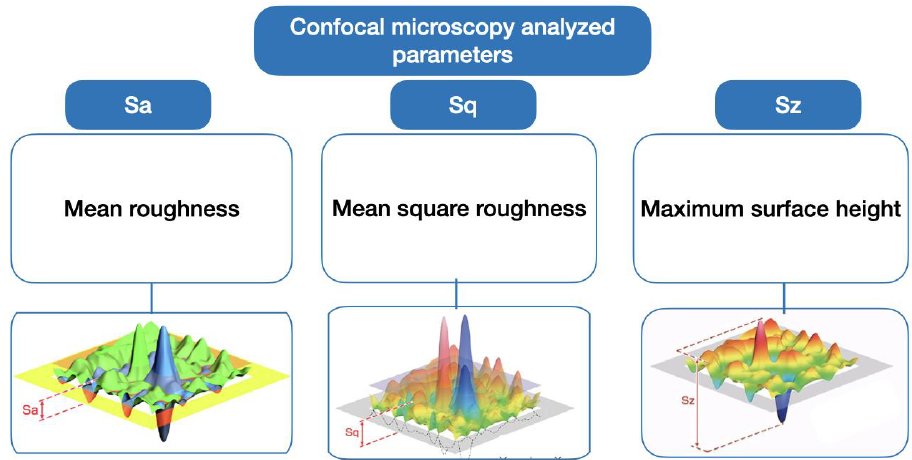
Figure 1. Scheme of confocal microscopy analyzed parameters: Sa (mean roughness), Sq (mean square roughness), and Sz (Maximum surface height).